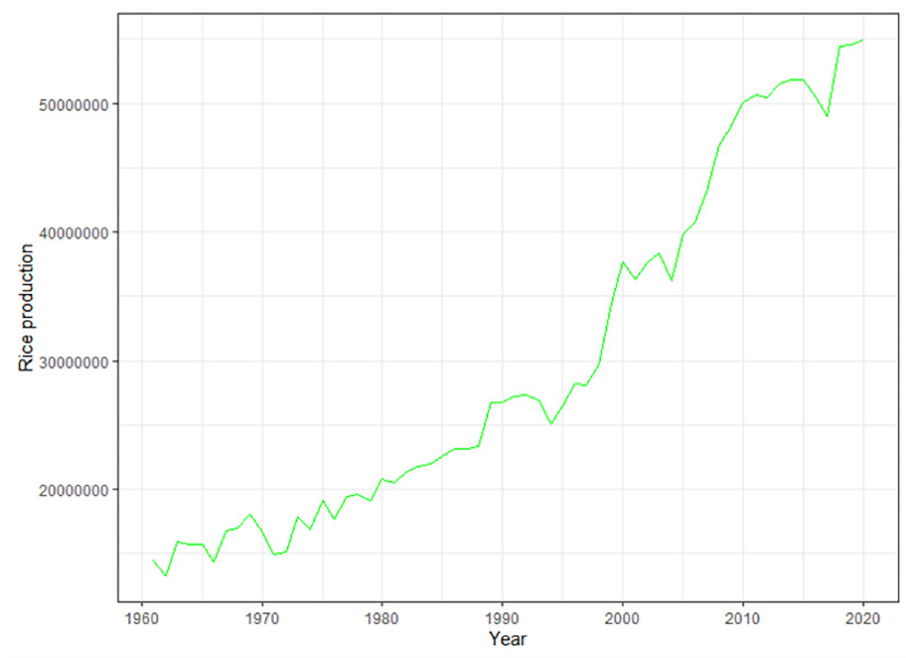
Fig 3. A time series plot for rice production in Bangladesh from 1961 to 2020.